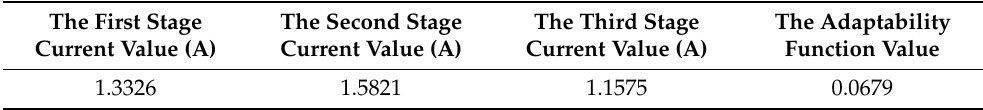
Table 1. Simulation results of three-stage constant current charging